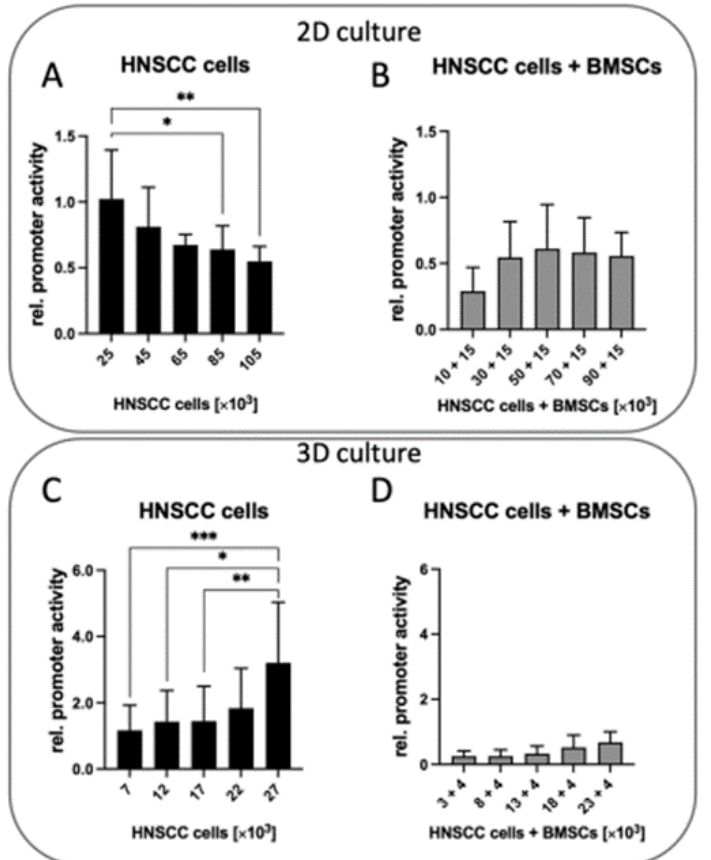
Figure 5. Pooled analysis of MMP-9 promoter activity in three HNSCC cell lines PCI 1, 13 and 68. ( A , B ): MMP-9 promoter activity in adherent 2D cell culture. ( A ): The mono-culture of HNSCC cells